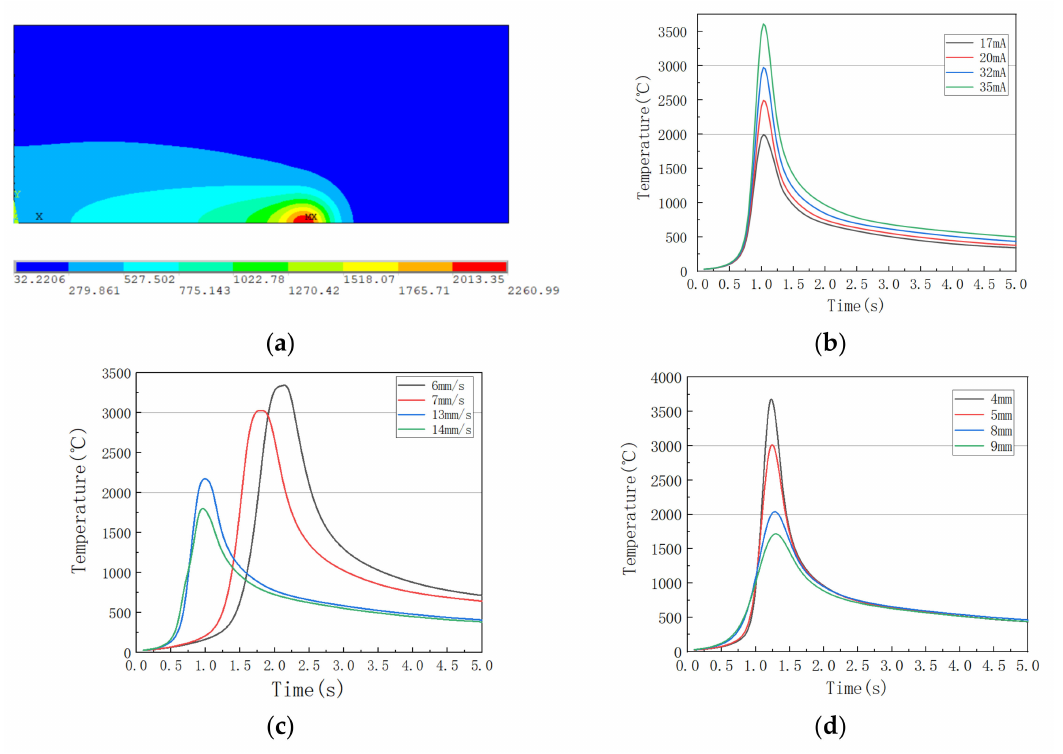
Figure 1. Temperature value range under different process parameters. ( a ) Temperature distribution of the melt pool. ( b ) Effect of electron beam flow on the melt pool temperature. ( c ) Effect of scanning speed on the melt pool. Temperature. ( d ) Effect of beam spot diameter on the melt pool